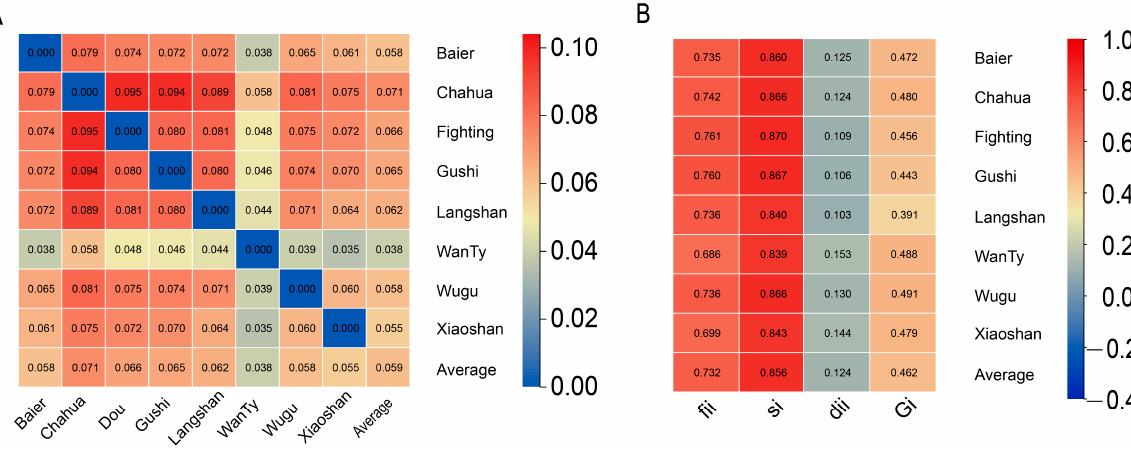
Figure 2. ( A ) Nei’s minimum genetic distance inter-breed and ( B ) intra-breed diversity